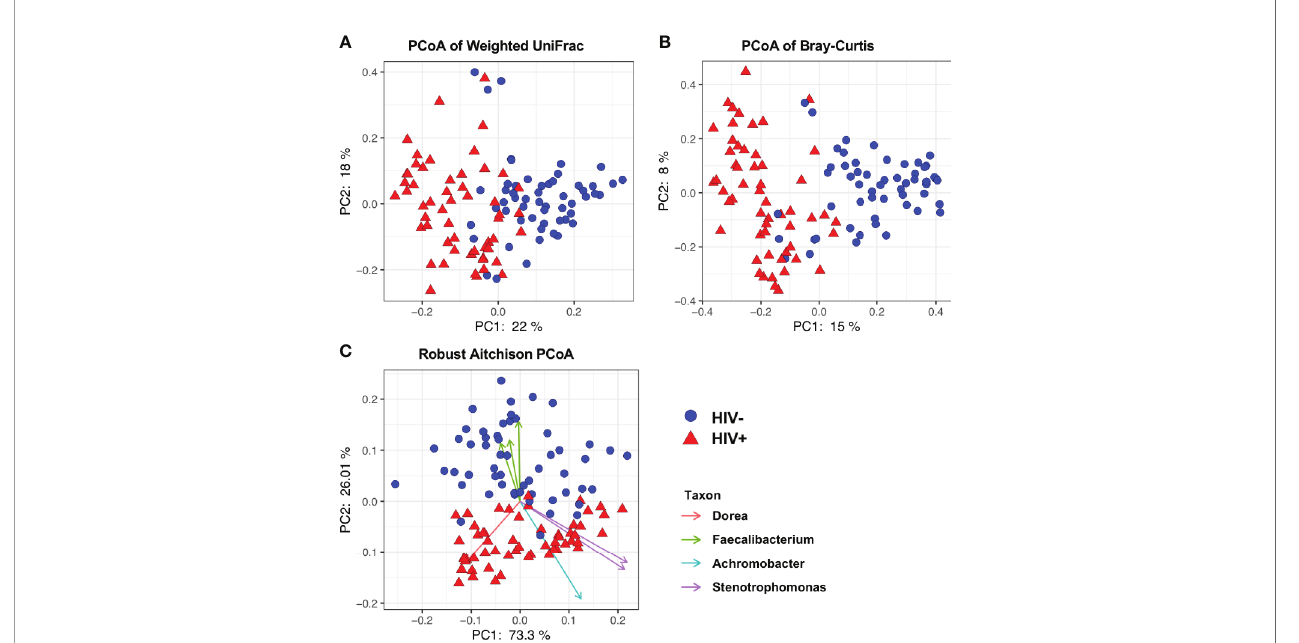
FIGURE 3 | Beta diversity of fecal microbiome in HIV-1 uninfected and infected Ghanaian adults. (A) Principal Coordinates Analysis (PCoA) of weighted Unifrac distances in fecal microbiome in HIV- and HIV+ individuals. (B) PCoA of Bray-Curtis distances in HIV- and HIV+. (C) PCoA of Aitchison distances in HIV- and HIV+. Seven representative amplicon sequence variants (ASV) in fl uencing the observed segregation are shown. These analyses indicate segregation between HIV- and HIV+.